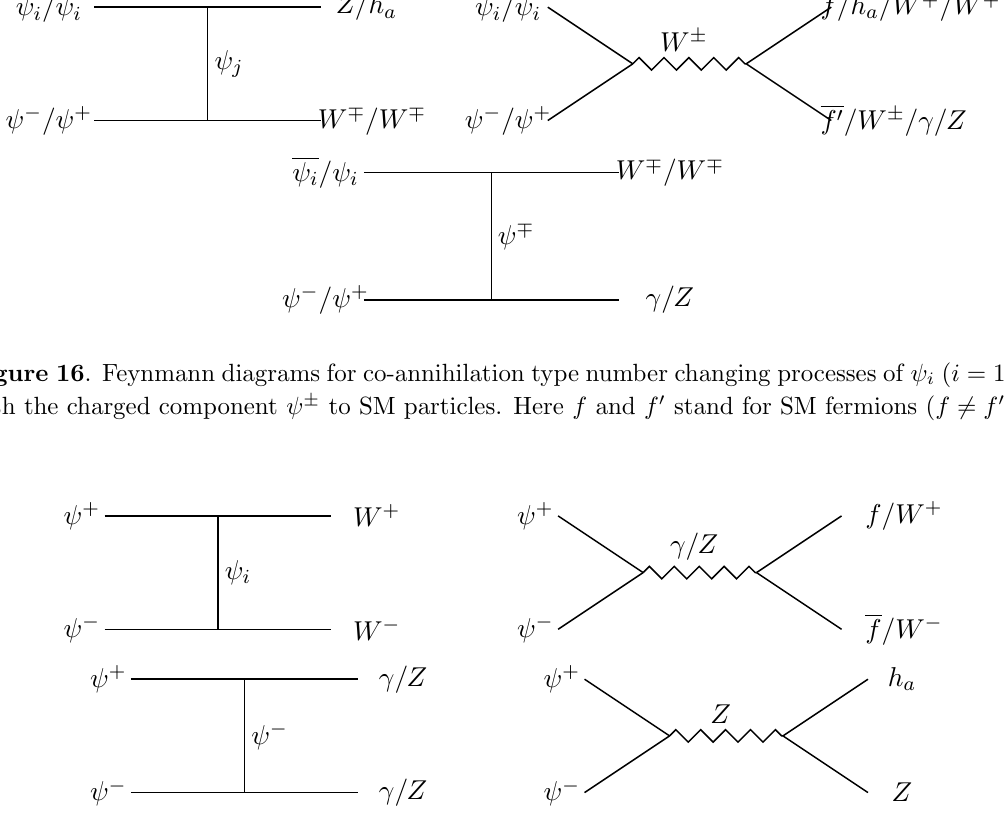
Figure 17 . Feynmann diagrams for charged fermionic